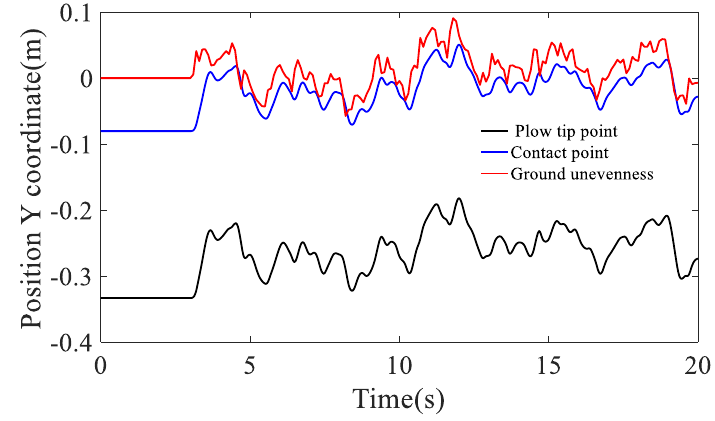
Figure 11. Position coordinate curves of each point.